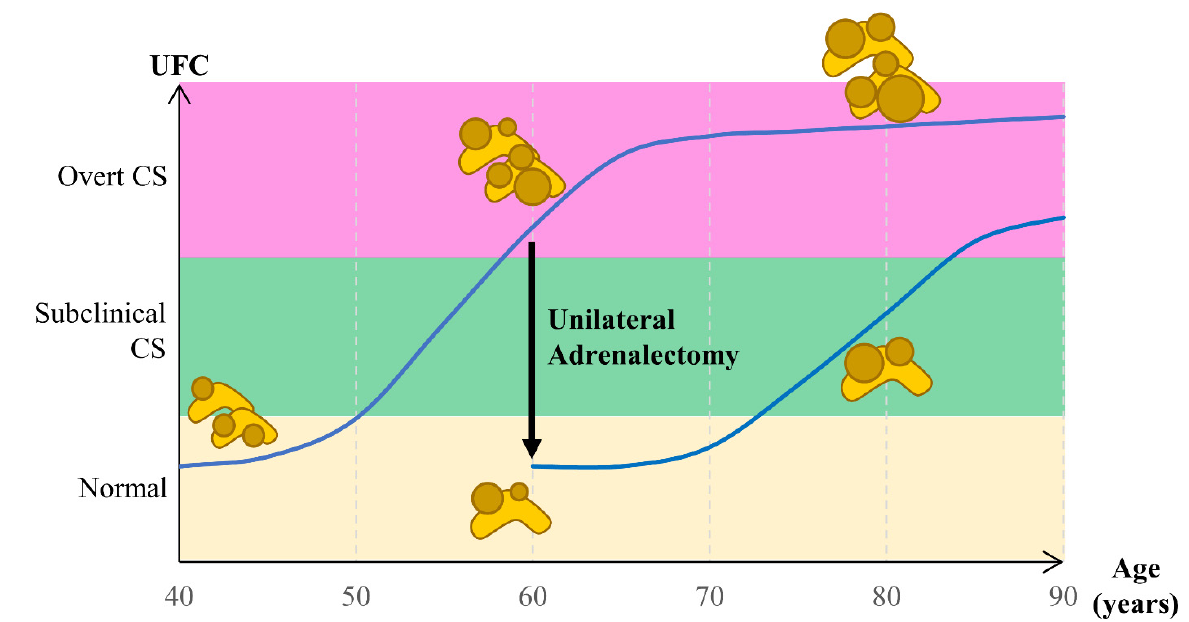
Figure 2. Evolution of cortisol secretion in bilateral adrenal hyperplasia over time and impact of unilateral adrenalectomy.